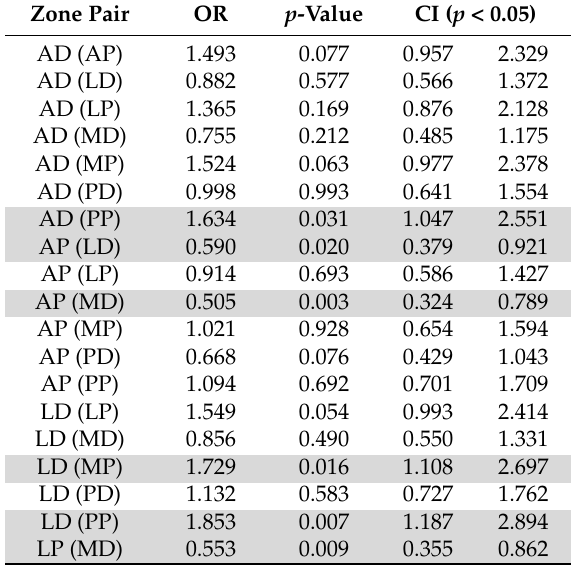
Table 5. The odds of observing a higher corrosion score at a primary zone compared with a reference zone.